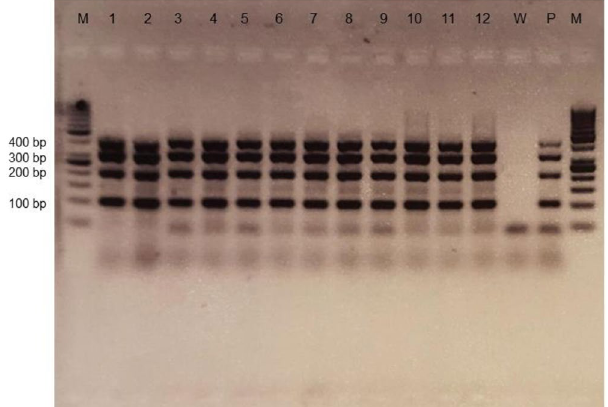
Figure 4. PCR results of Cryo-Gel samples (lane 1–4), OCT samples (lane 5–8) and samples without compound (lane 9–12) showing a product at 400, 300, 200 and 100 bp. All experiments included a positive control (P) and a negative water control (W).